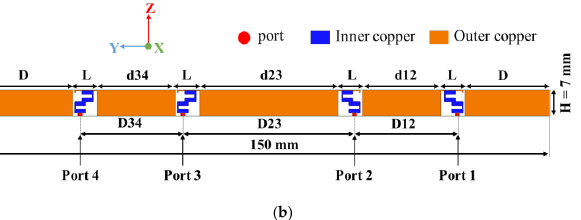
Figure 1. Geometry and dimensions of the proposed triple-band eight-element antenna array in millimeters: ( a ) Prospective view; ( b ) Side view. 3. Antenna Analysis In order to understand the mechanism of the proposed MIMO antenna system, the design evolution, simulated surface current distribution, and the optimal parameter analysis of the antenna element have been studied.